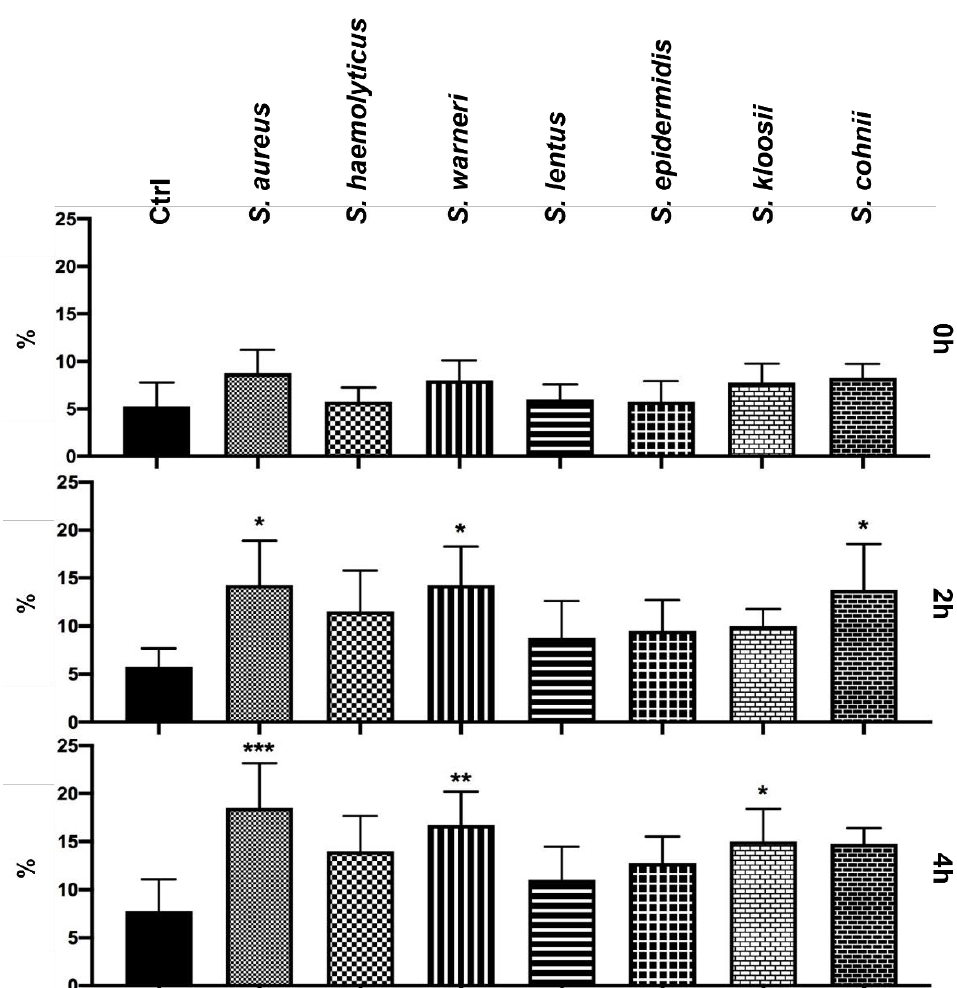
Figure 5. Changes in the sperm DNA fragmentation during the 4 h bacteria/sperm co-incubation in vitro at 37 °C. Each group treated with Staphylococcus species was compared with the Ctrl group with no added bacteria. Each bar represents the mean percentage of spermatozoa with the fragmented DNA inside the sperm head ± S.E.M. Five individual experiments were performed to obtain these data. The level of statistical significance was set at * p < 0.05; ** p < 0.01; *** p < 0.001.